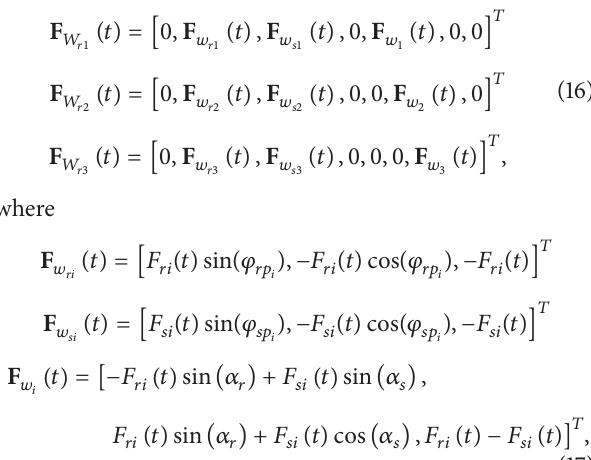
Figure 4: The mesh stiffness of planet 1 with and without tooth breakage: (a) planet-sun gear pair, (b) planet-ring gear